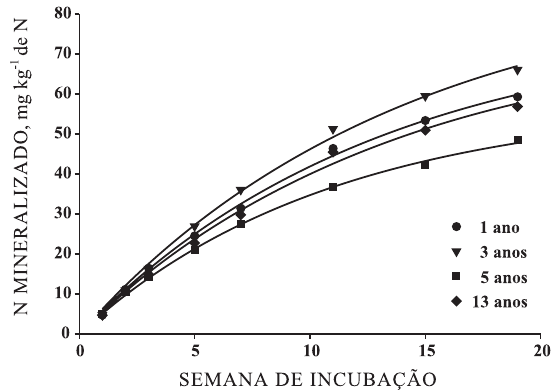
Figura 2. Curvas de N mineralizado acumulado du- rante período de incubação de solos sob planta- ções de eucalipto de diferentes idades, ajusta- das ao modelo exponencial simples para obten- ção do N e da constante de o